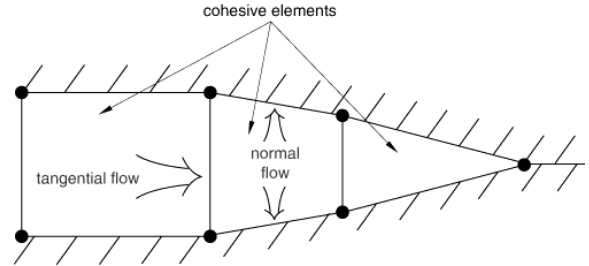
Figure 1. Fracturing flow pattern within the cohesive element.